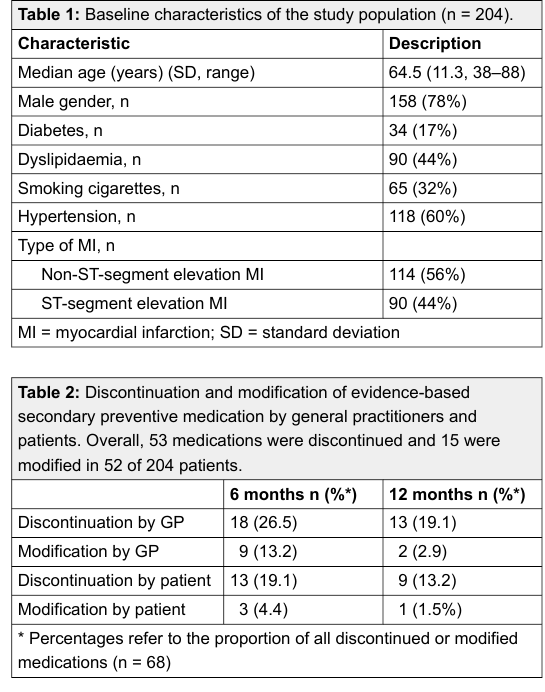
Table 3: Reasons for discontinuation/modification of secondary prevention medication after myocardial infarction (n = 68) 6 and 12 months after discharge. Bradycardia,